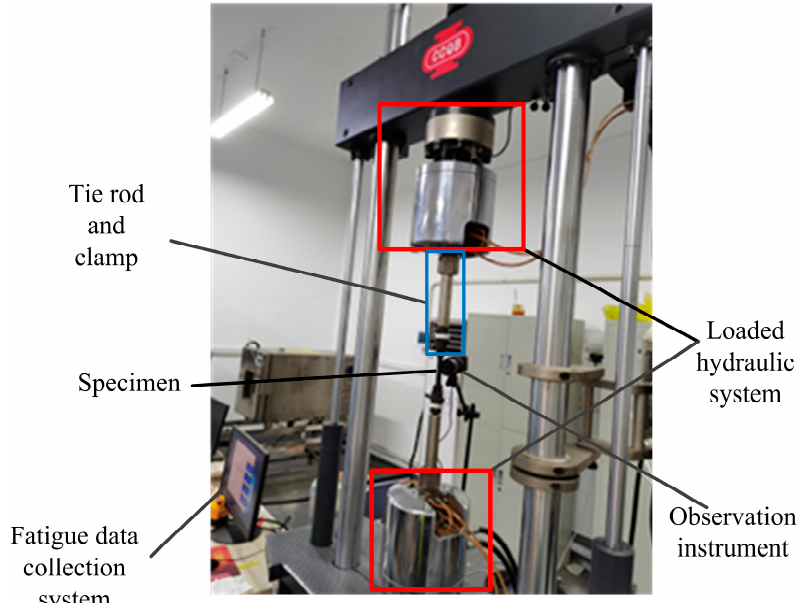
Figure 3. CCQB electro ‐ hydraulic servo fatigue testing system.